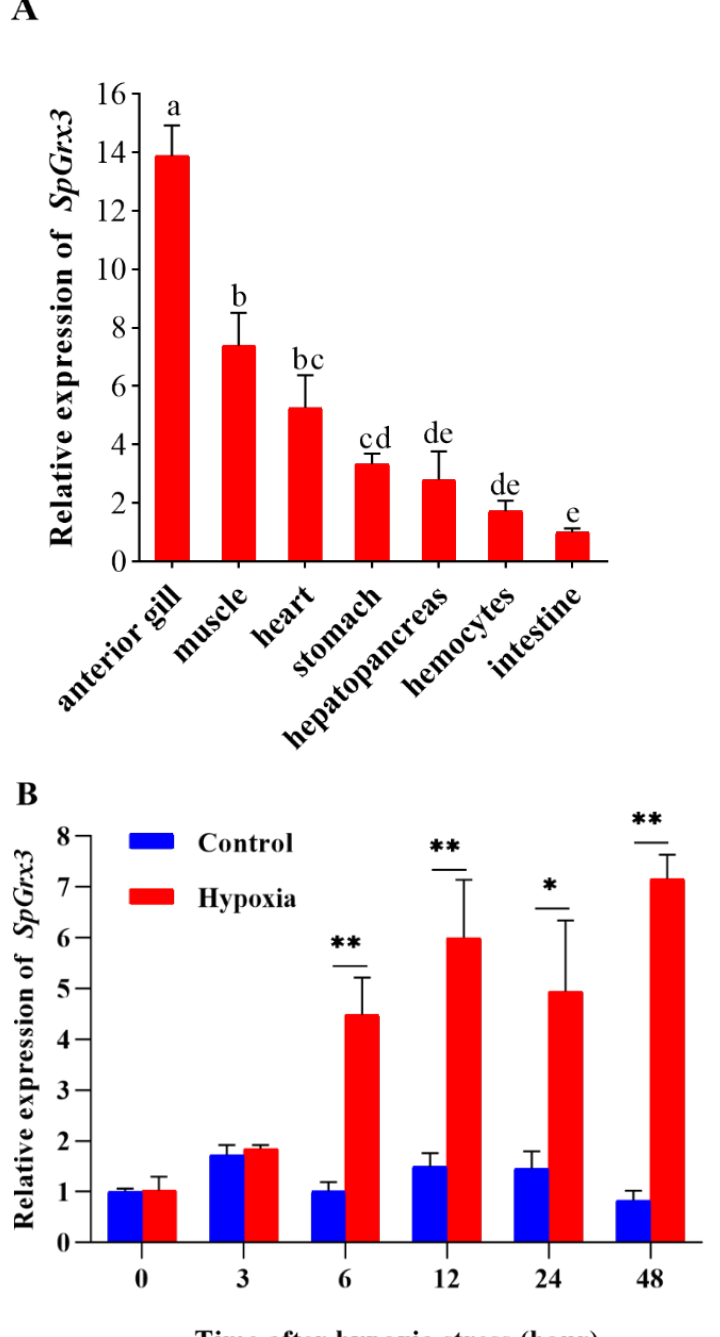
Figure 4. Relative expression levels of SpGrx3 . ( A ) The mRNA level of SpGrx3 in different tissues. Data are presented as the mean ± SD (N = 3). Different letters denote significant differences ( p < 0.05). ( B ) The expression profiles of SpGrx3 in gills after hypoxia. Data are presented as the mean ± SD (N = 3). *: p < 0.05, **: p < 0.01.